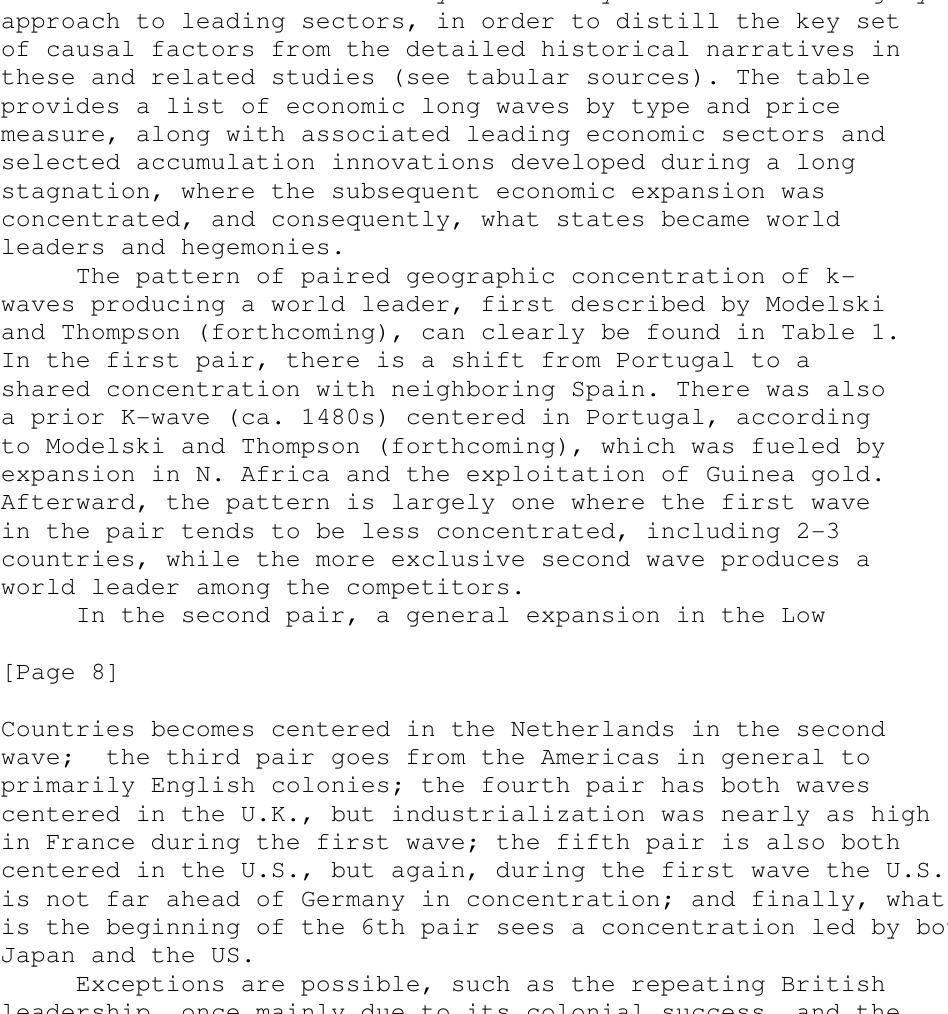
Economic Sources of World Leadership and Hegemony: K-Waves, Leading Sectors, and Concentrations: